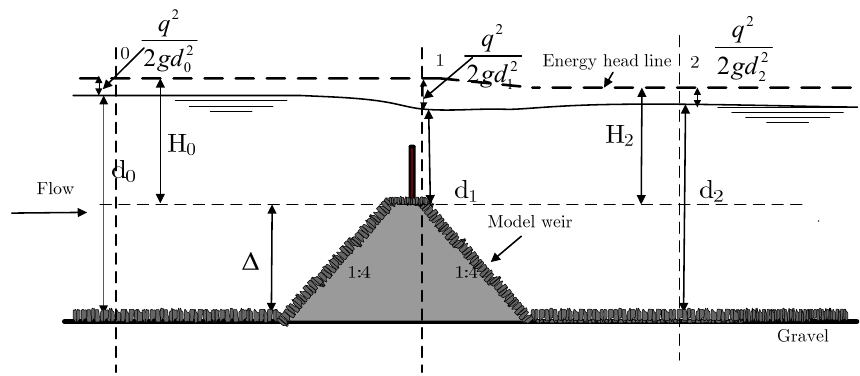
Fig. 3. Side-view of the vegetated oblique weir and flow over the weir with rough surfaces.